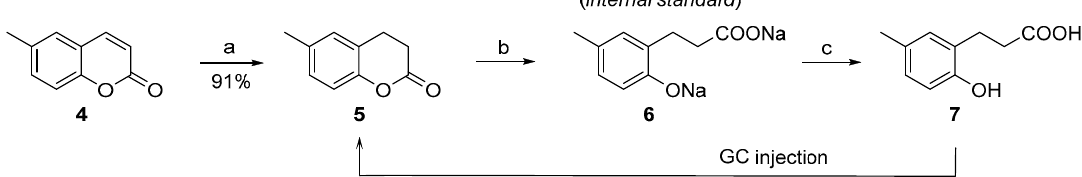
Figure 3. Synthesis of the internal standard 6 . Reagents and conditions: ( a ) H 2 , AcOH, Pd/C catalyst, 8 h, r.t.; ( b ) NaOH/EtOH, 60 °C, 10 min; ( c ) HCl aq. (3% w / v).